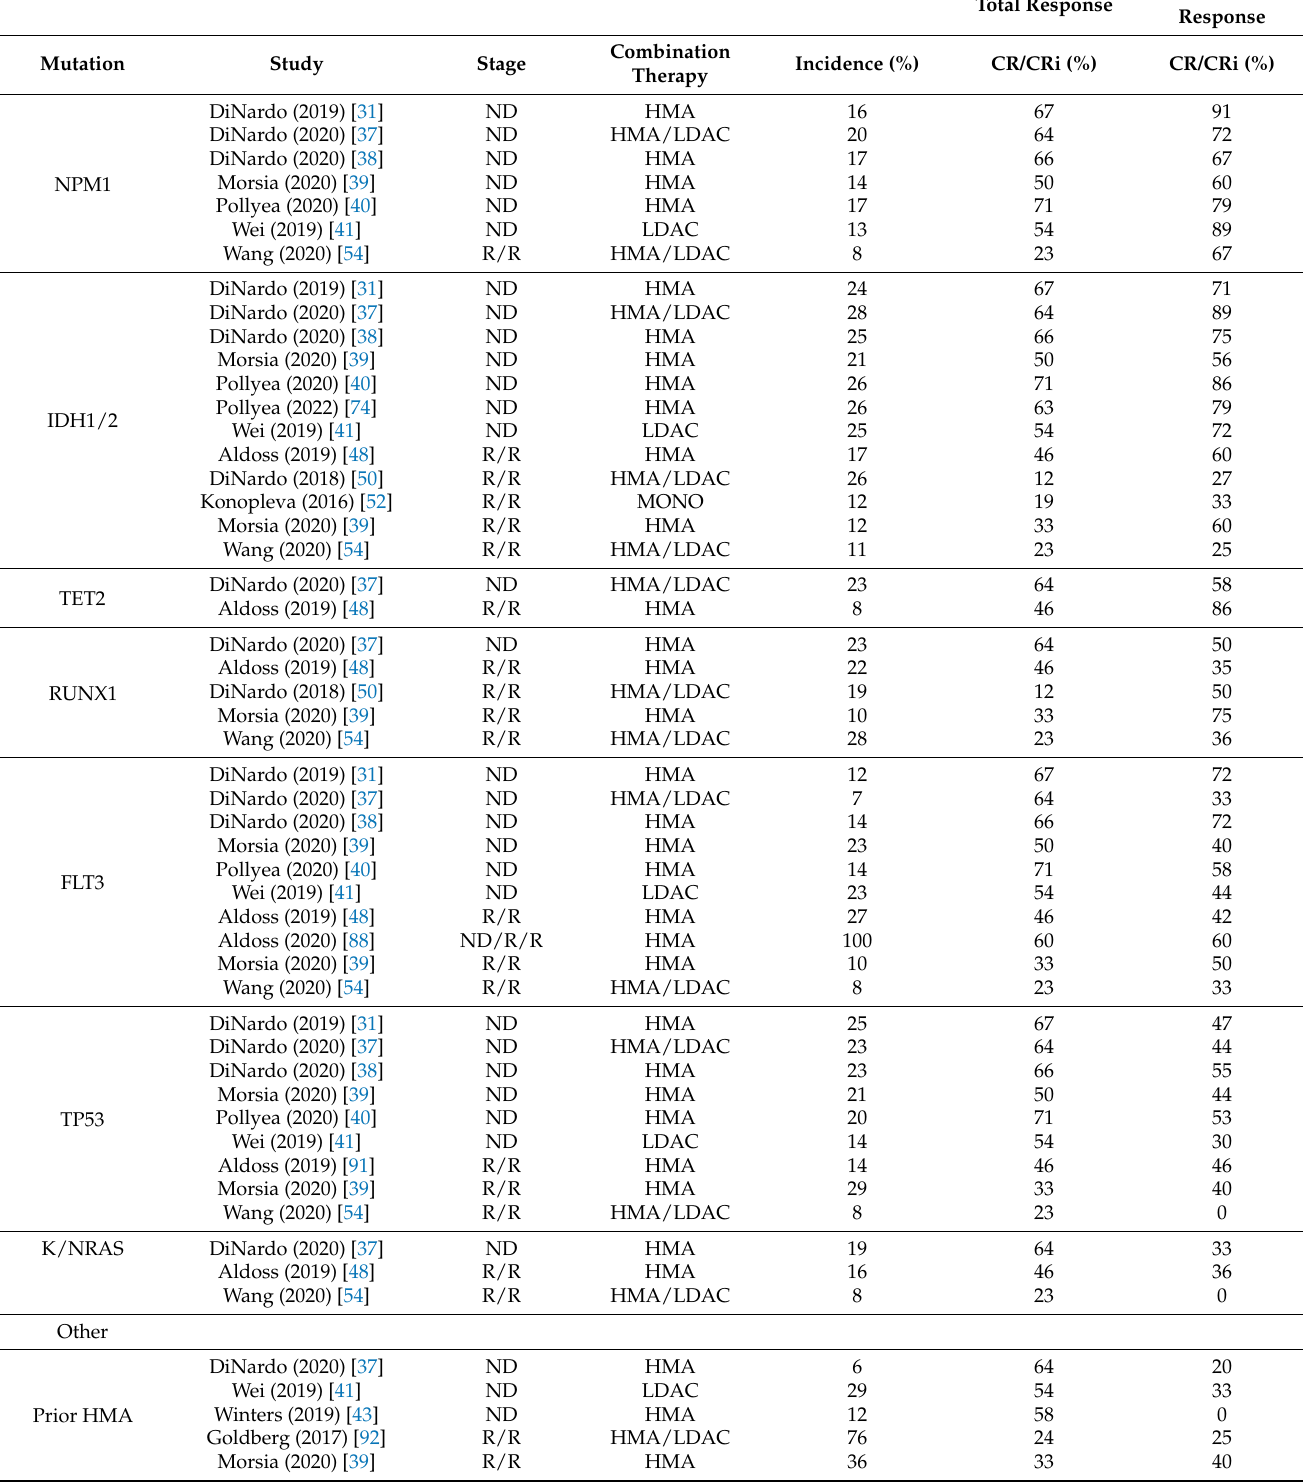
Table 3. Response rates for venetoclax-based therapy for different